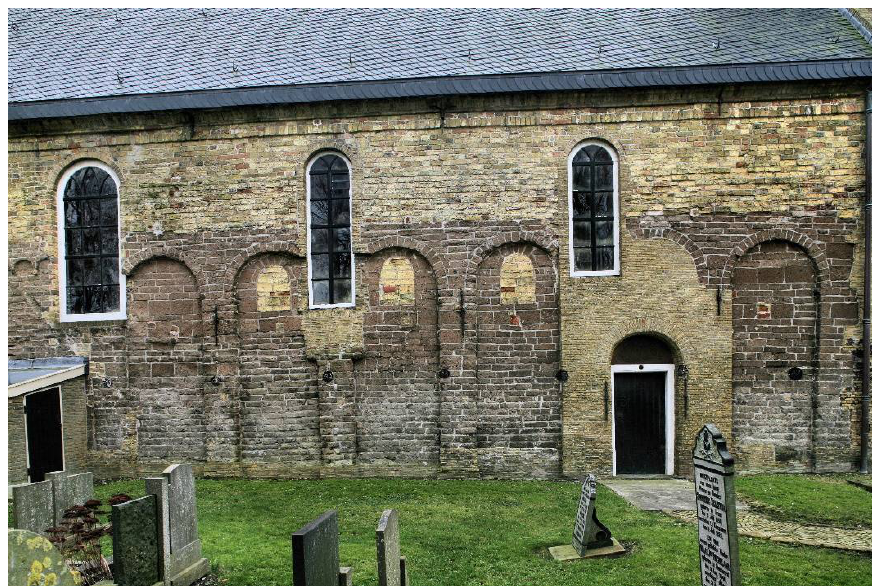
Figure 9. The north wall of the nave in Kimswerd (Frisia) was erected around 1100 in tuff stone brought from the Eifel region in Germany (photo: Regnerus Steensma archive).